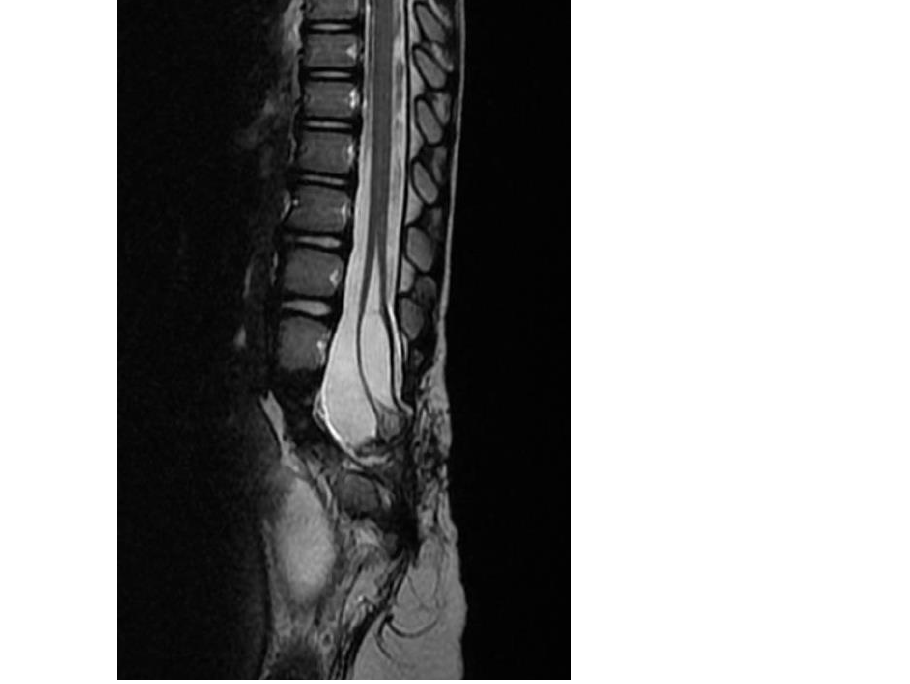
Figure 4. Post-operative T2 sequence in the sagittal view demonstrates a significant reduction in the size of the intramedullary syrinx.